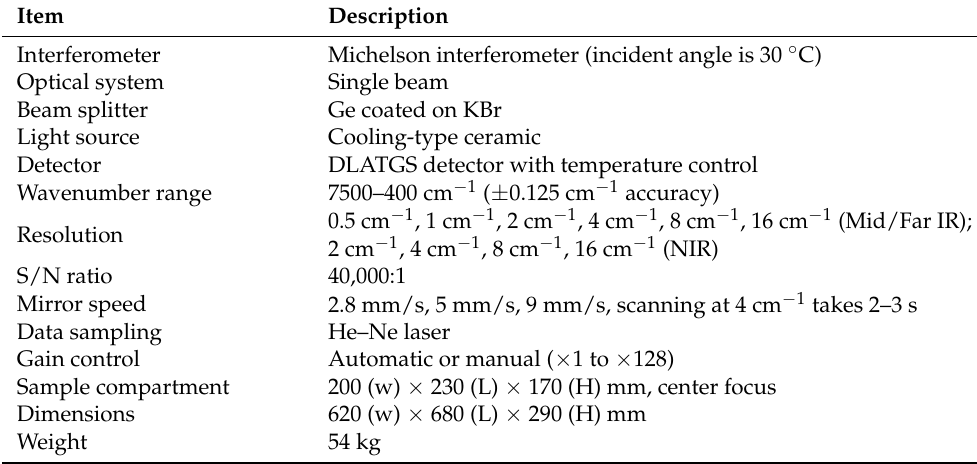
Table 2. IRPrestige-21 specifications and parameters.